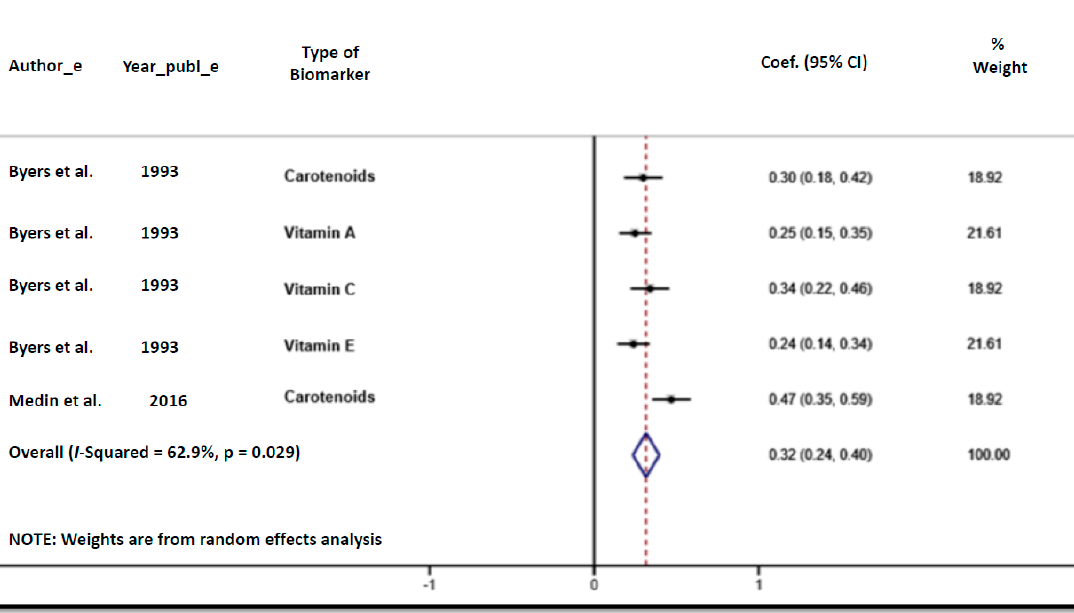
Figure 2. Forest-plot for correlation coefficients of fruit and vegetable consumption assessed by questionnaires and blood biomarkers.